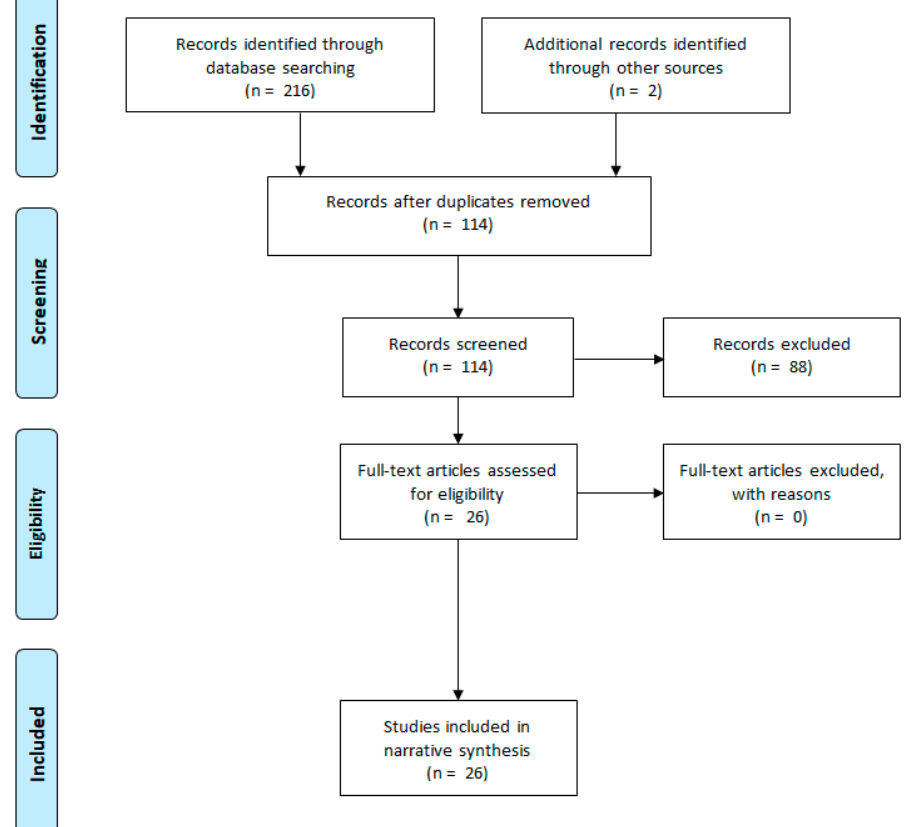
Figure 1. Flow diagram of the narrative review. 245